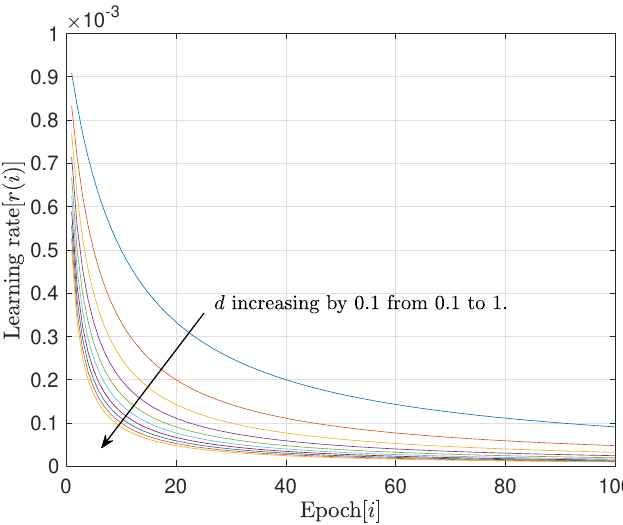
Figure 3. A decaying learning rate as an epoch increases. r init = 10 − 3 , and d increases by 0.1 from 0.1 to